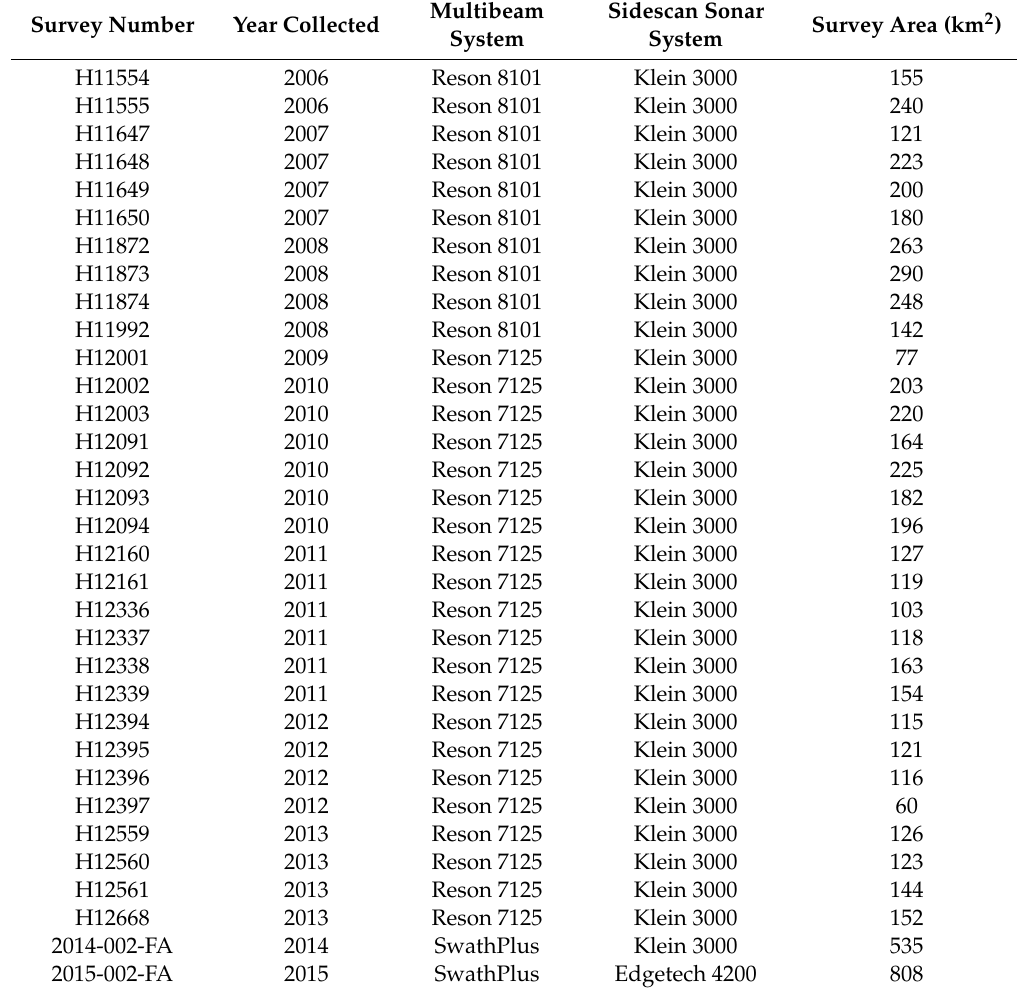
Table 1. National Oceanic and Atmospheric Administration and National Ocean Service Hydrographic surveys and USGS geophysical surveys used in this study